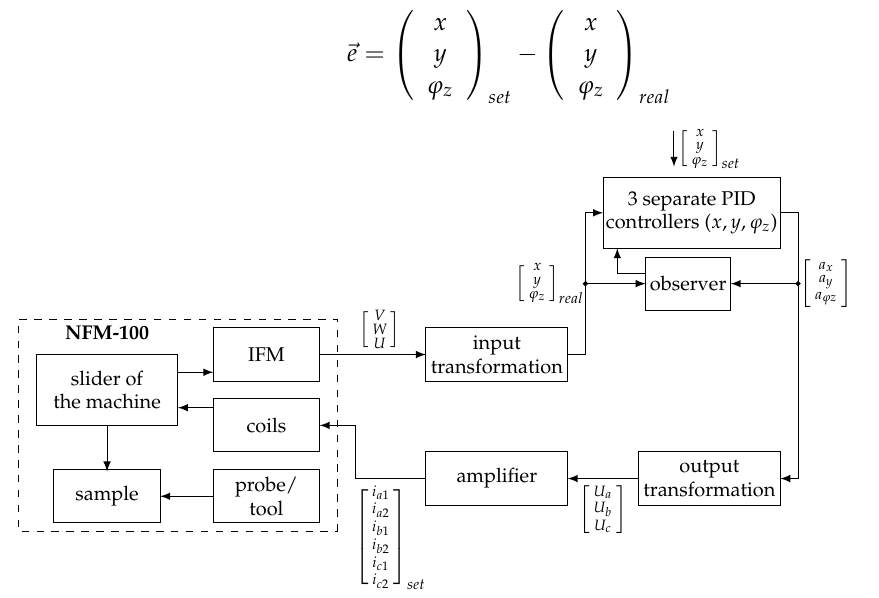
Figure 4. Control scheme of the NFM-100 and its positioning